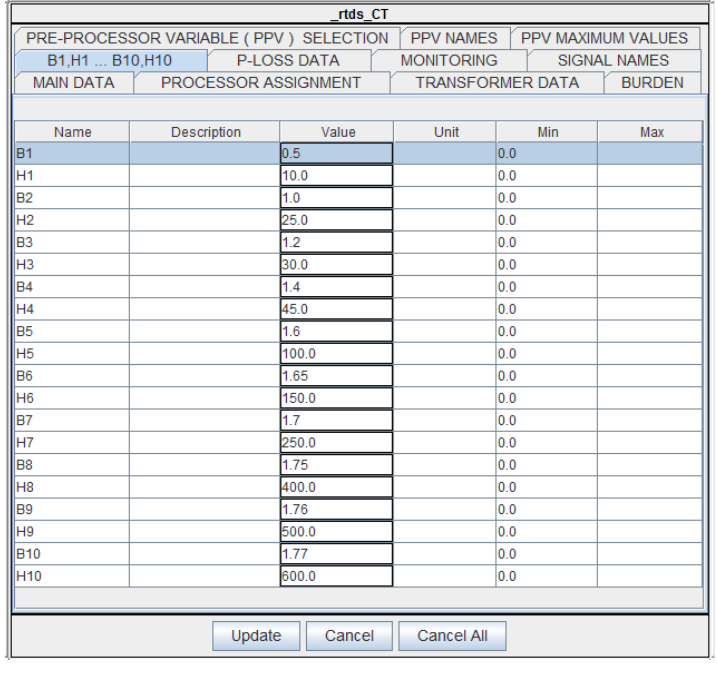
Figure 6. RTDS Standard CT model.